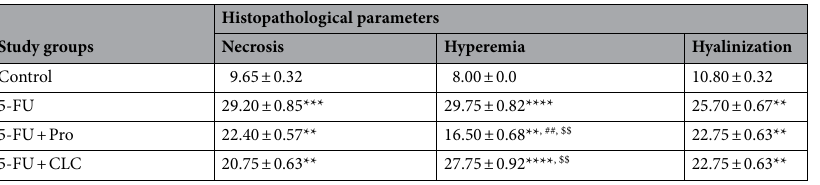
Table 4. Histopathological parameters of study groups. Values are expressed as mean ± standard deviation (SD). Groups: Control, Normal saline; 5-FU, 5-FU 125 mg/kg; 5-FU + Pro, 5-FU 125 mg/kg + Propolis ethanolic extract 250 mg/kg/d; 5-FU + CLC, 5-FU 125 mg/kg + Colchicine 5 mg/kg/d. **, ***, and **** Indicate statistically significant difference compared to the control group (p < 0.01, p < 0.001, and p < 0.0001, respectively). ## Indicate statistically significant difference compared to the 5-FU group (p < 0.01). $$ Indicate statistically significant difference between the treatment groups (p < 0.01).